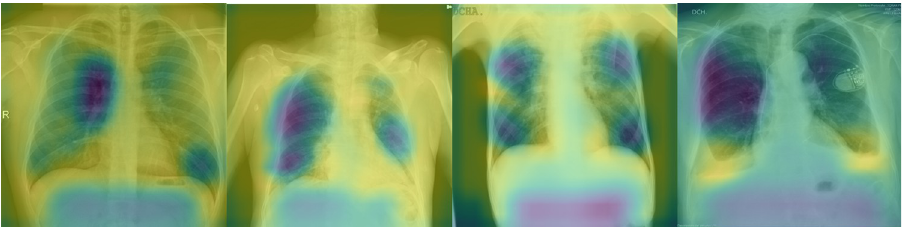
Fig 8. Gradient-weighted Class Activation Mapping (Grad-CAM): From left to right–Negative for pneumonia, typical appearance, indeterminate and atypical appearance. The heat map of the activations show that the area of high activations shrinks in diseased images as compared to healthy